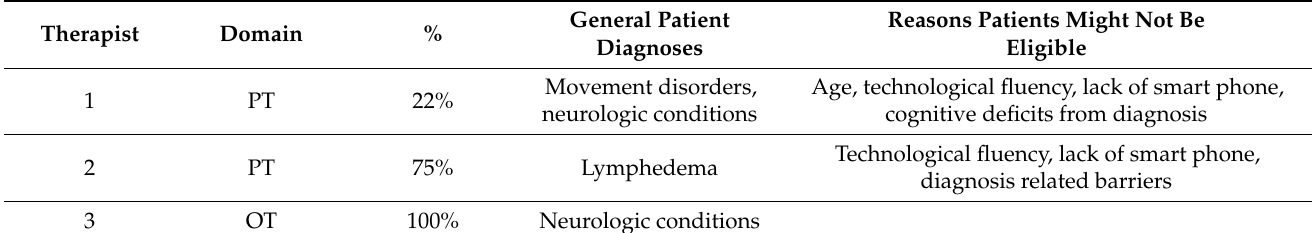
Table 9. Estimated percent of eligible patient population that could benefit from the SEAM system, including descriptions of the general population and reasons they might not be